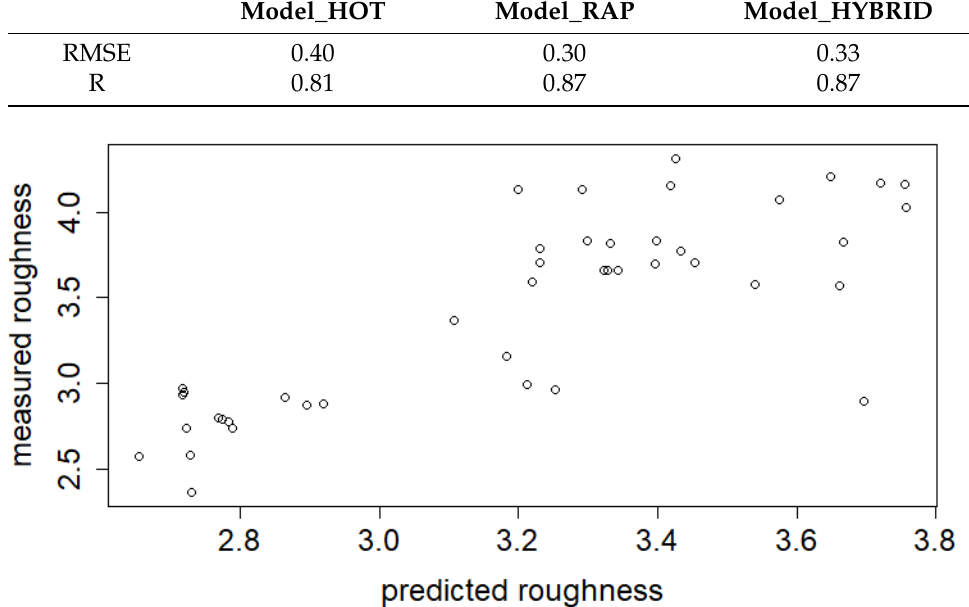
Figure 1. Scatter plot for predicted and actual values in test set for